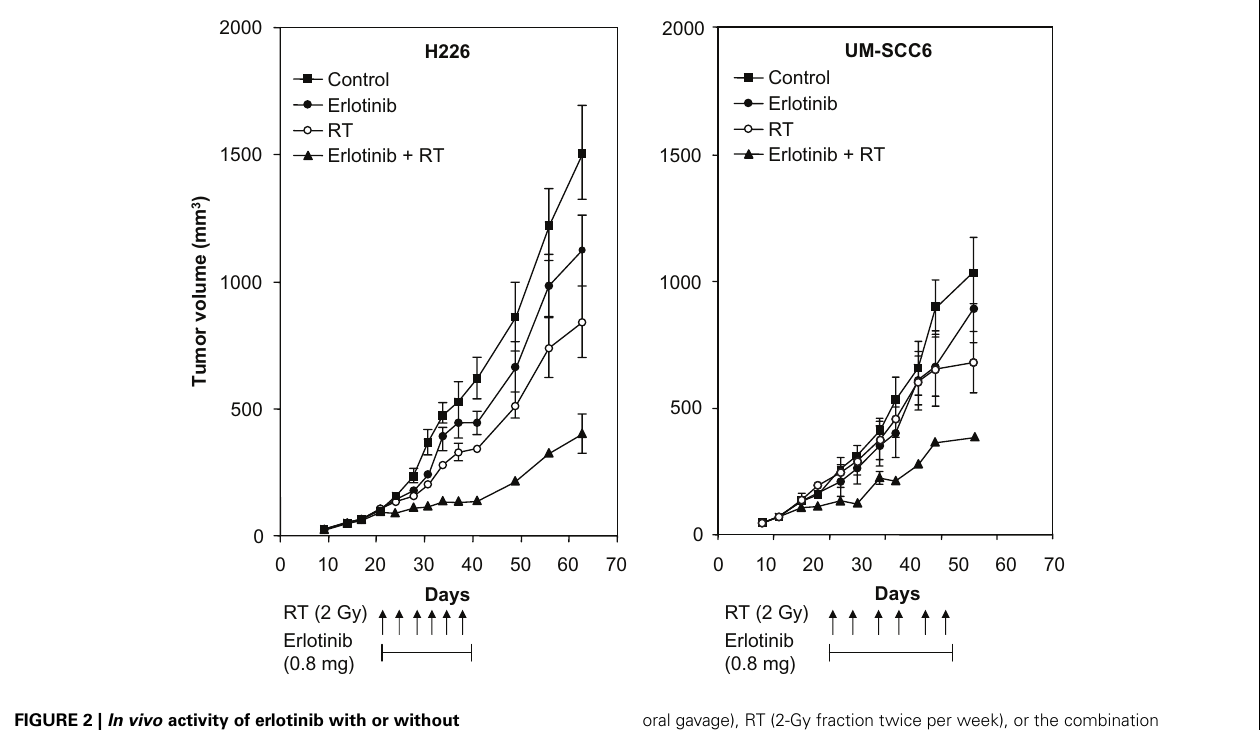
oral gavage), RT (2-Gy fraction twice per week), or the combination for 3weeks. Points, mean tumor size (mm 3 ; six mice per treatment group). Reprinted with permission from Chinnaiyan et al. (2005, Figure 6).